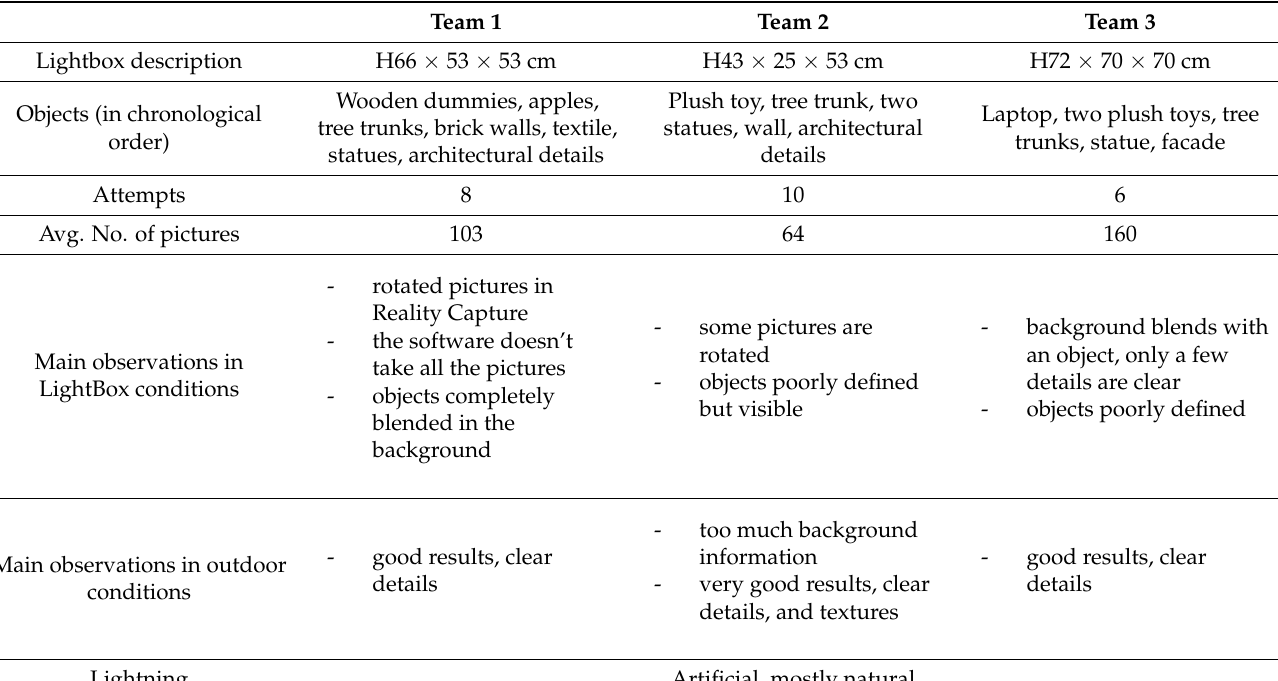
Table 2. Students’ observation worksheet